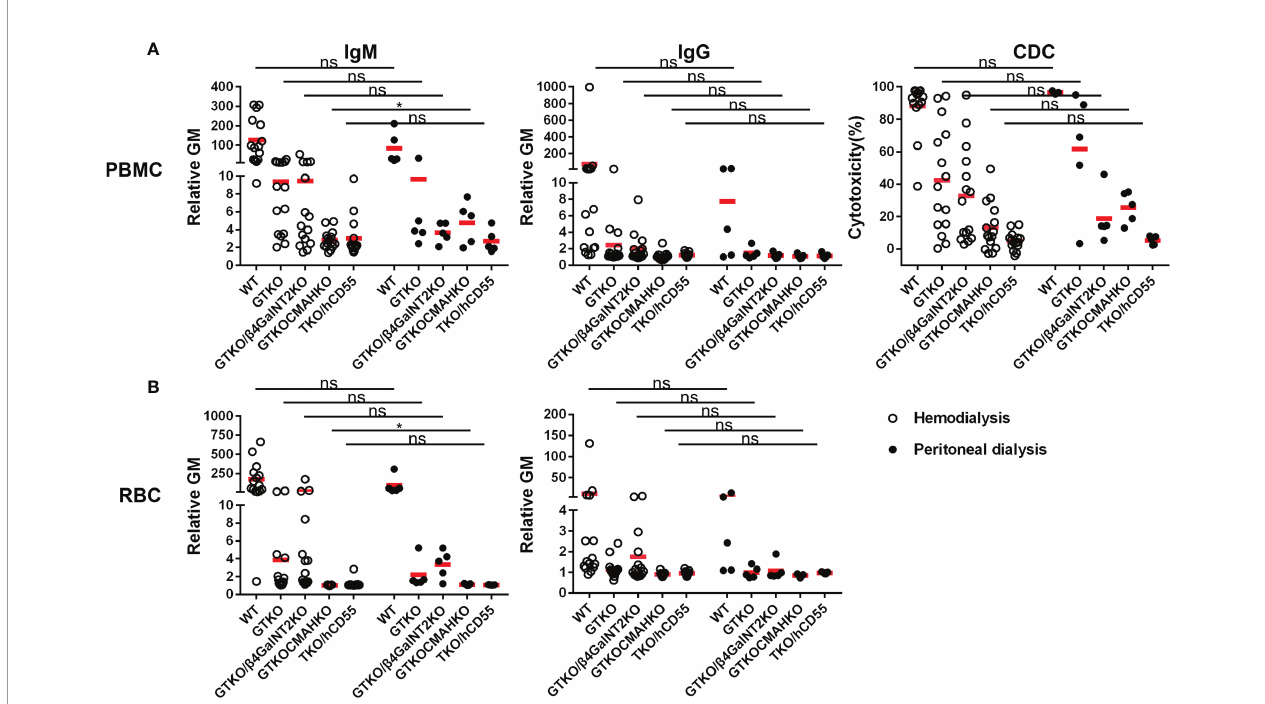
FIGURE 4 | Comparison of serum IgM/IgG binding and CDC to PBMCs or RBCs from WT, GTKO, GTKO/ b 4GalNT2KO, GTKO/CMAHKO and TKO/hCD55 pig in patients receiving hemodialysis or peritoneal dialysis. (A) There were no differences in IgM/IgG binding or CDC to WT, GTKO, GTKO/ b 4GalNT2KO, and TKO/hCD55 PBMCs, but IgM binding to GTKO/CMAHKO to PBMCs was signi fi cantly lower in hemodialysis patients. (B) There were no differences in IgM/IgG binding to WT, GTKO, GTKO/ b 4GalNT2KO, GTKO/CMAHKO, and TKO/hCD55 RBCs, but IgM binding to GTKO/CMAHKO to RBCs was again signi fi cantly lower in hemodialysis patients. (*p<0.05; ns=not signi fi